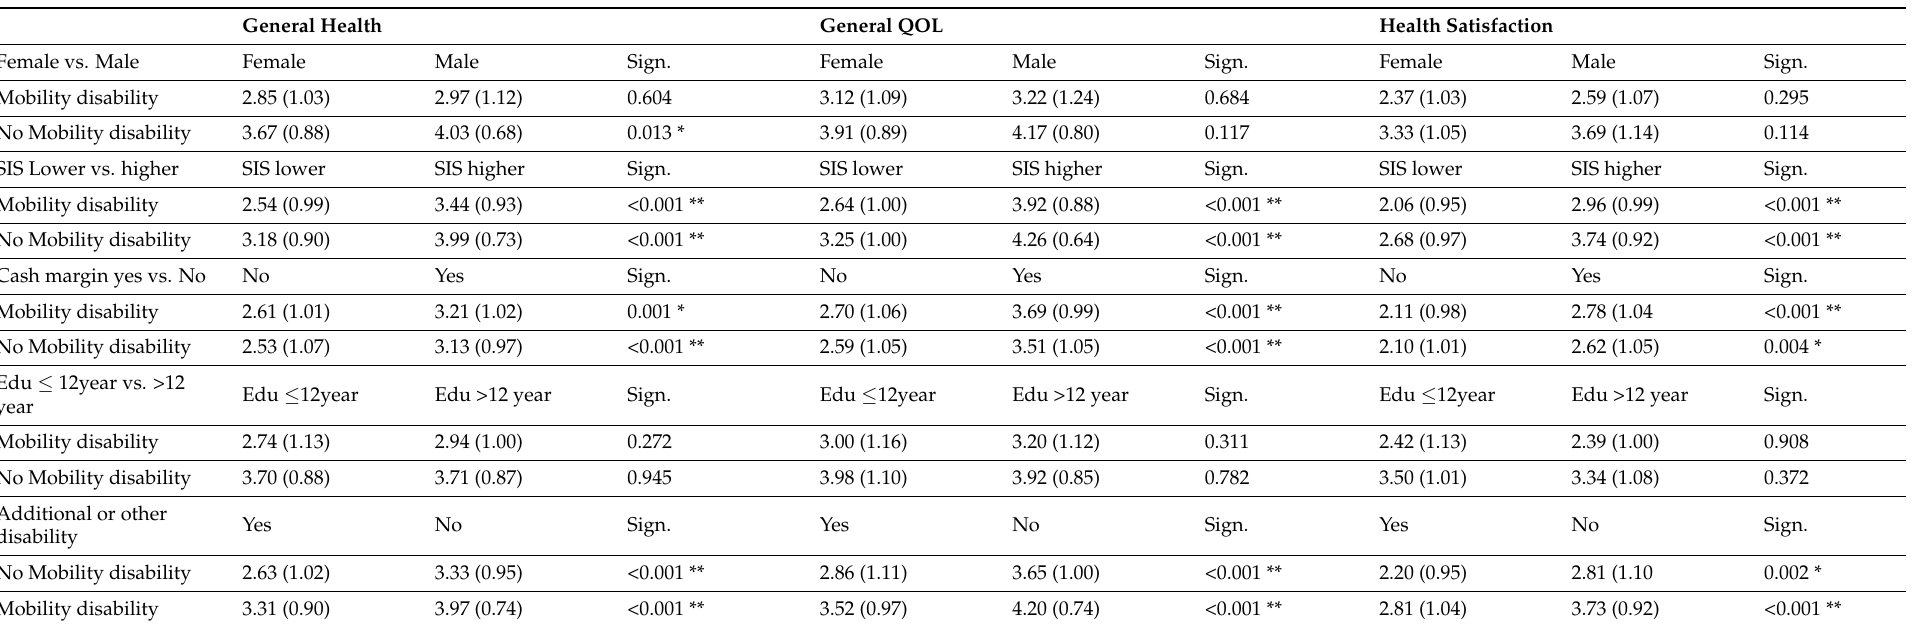
Table 4. Within-group associations for Sex, dichotomized SIS, cash margin, Education, other/additional disability WHOQOL-BREF items, [mean (SD)] p -value for Welch t-test